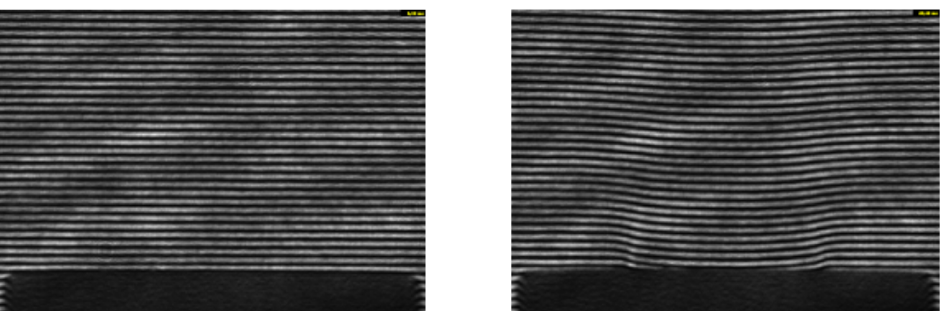
Figure 12. Interferometric images above the nozzle (black area at the lower edges) before gas-jet opening ( left ) and at 47.2 bar backing pressure 32 ms after triggering ( right )